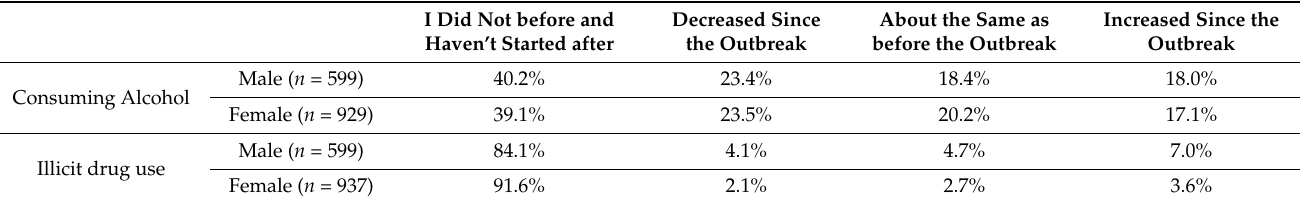
Table 5. Proportions of male and female adolescents reporting whether the COVID-19 outbreak changed their alcohol and illicit drug use